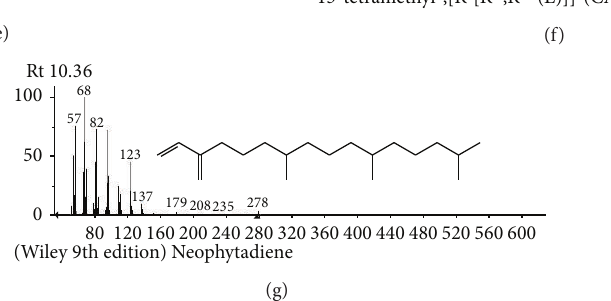
Figure 2: (a)–(g) Mass spectra of acetone extract with its products having the high concentration compared with NIST